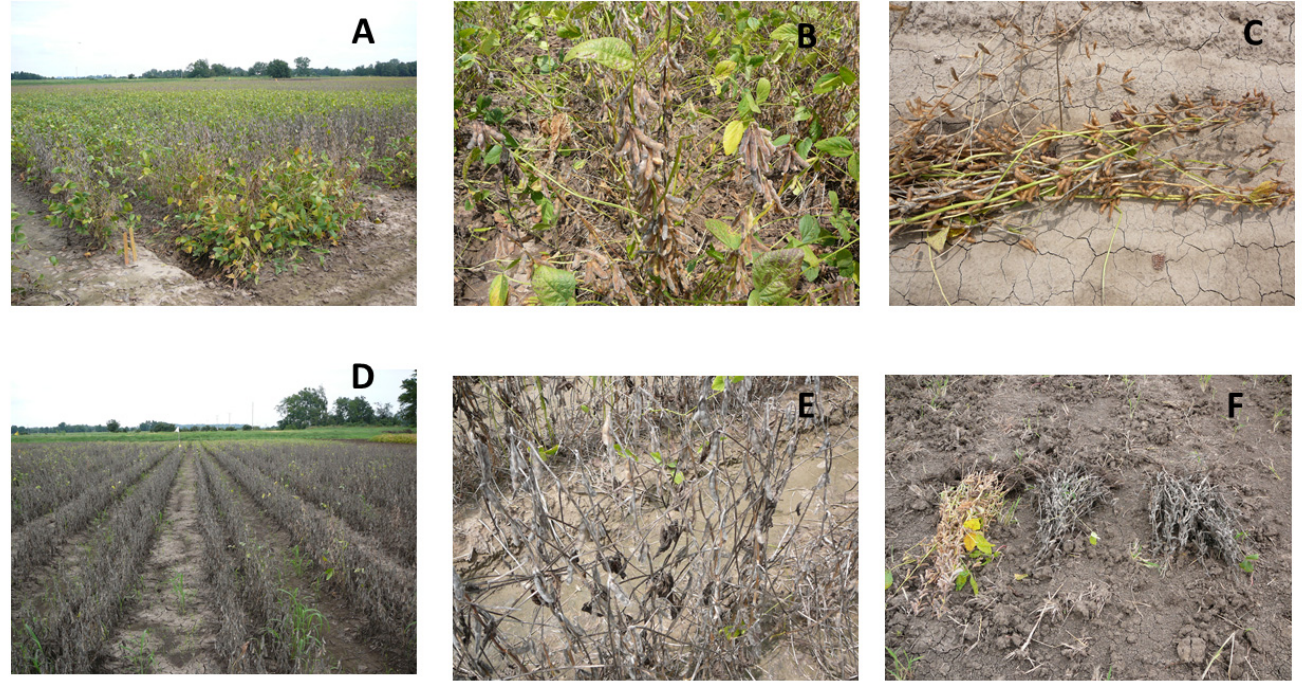
Figure 1. Charcoal rot of soybean in the field ( A – F ) under irrigated ( A – C ) and non-irrigated/drought ( D – F ). Notice the importance of irrigation management and the severity of charcoal rot under non- irrigation/drought conditions.